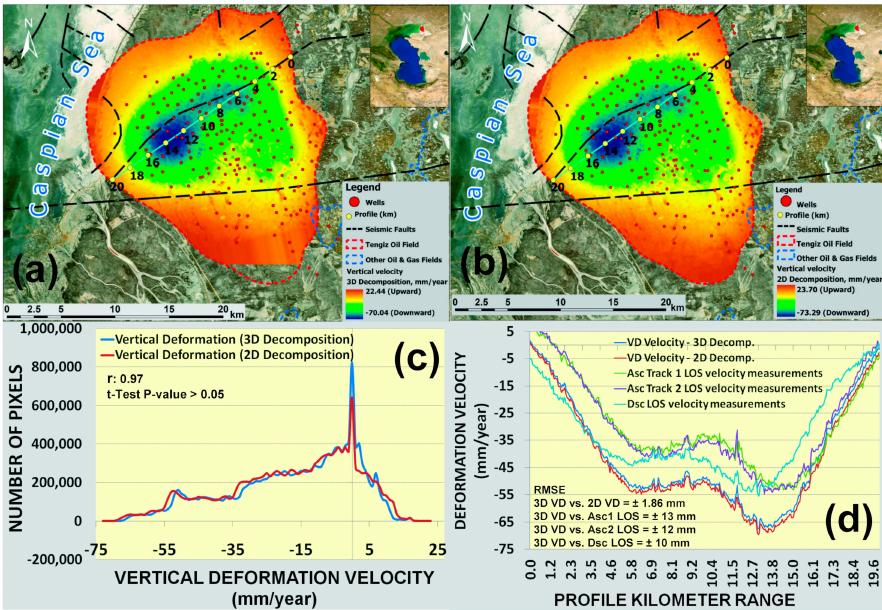
Figure 5. Vertical deformation velocity derived: ( a ) from 3D decomposition of 2 ascending and 1 descending LOS measurements; ( b ) from 2D decomposition of 1 ascending and 1 descending LOS measurements; ( c ) histogram of vertical deformation velocities derived from 3D and 2D decompo- sitions; ( d ) profiles of vertical deformation velocities derived from 3D and 2D decompositions and LOS